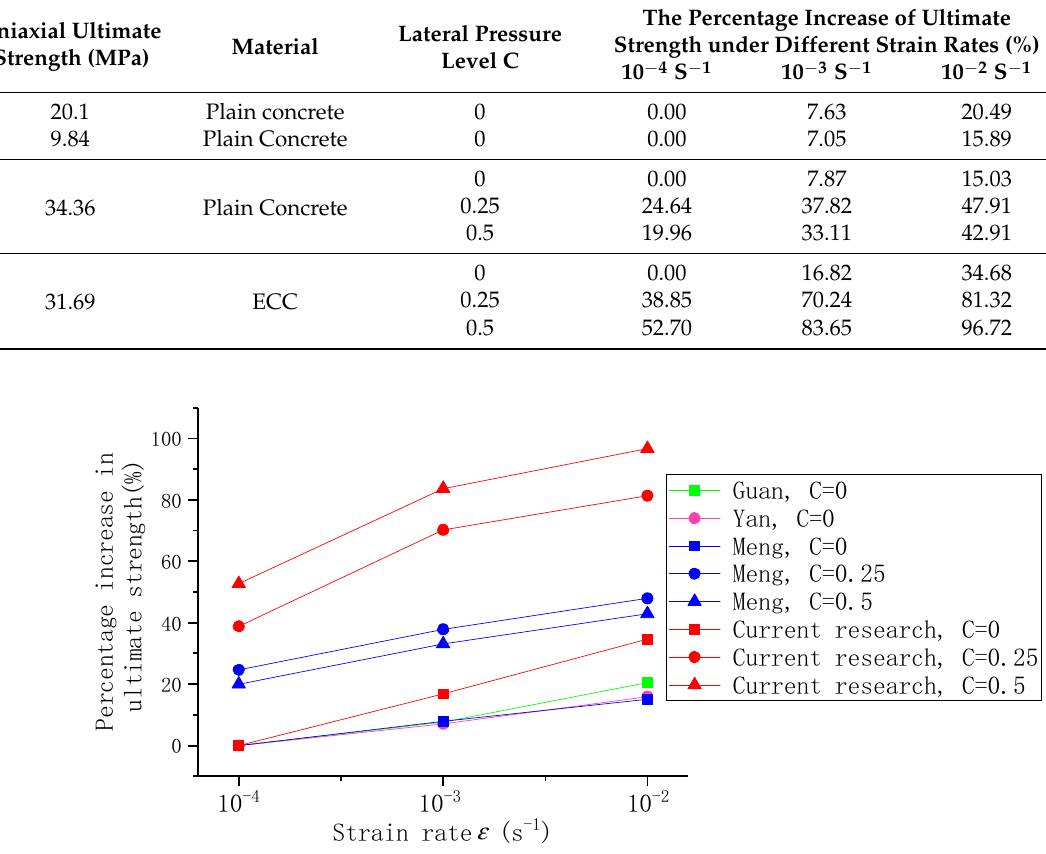
Table 10. Research results of strength by other researchers under different lateral pressure and strain rates.